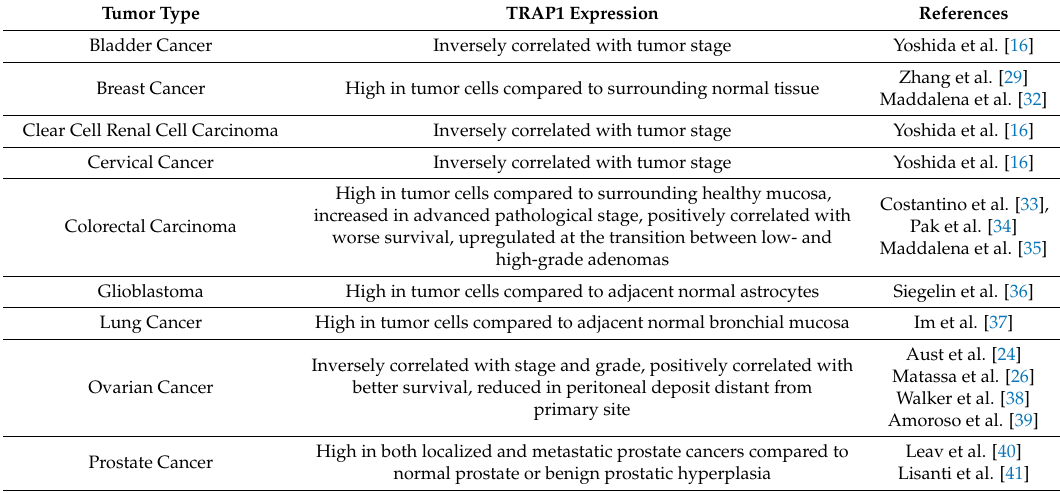
Table 1. Tumor Necrosis Factor Receptor-associated Protein 1 (TRAP1) is either positively or negatively selected in different tumors. Depending on the tumor type, TRAP1 expression is increased in the tumor compared to the normal tissues and further increases during progression and in metastatic sites or is lost in the later stages of the